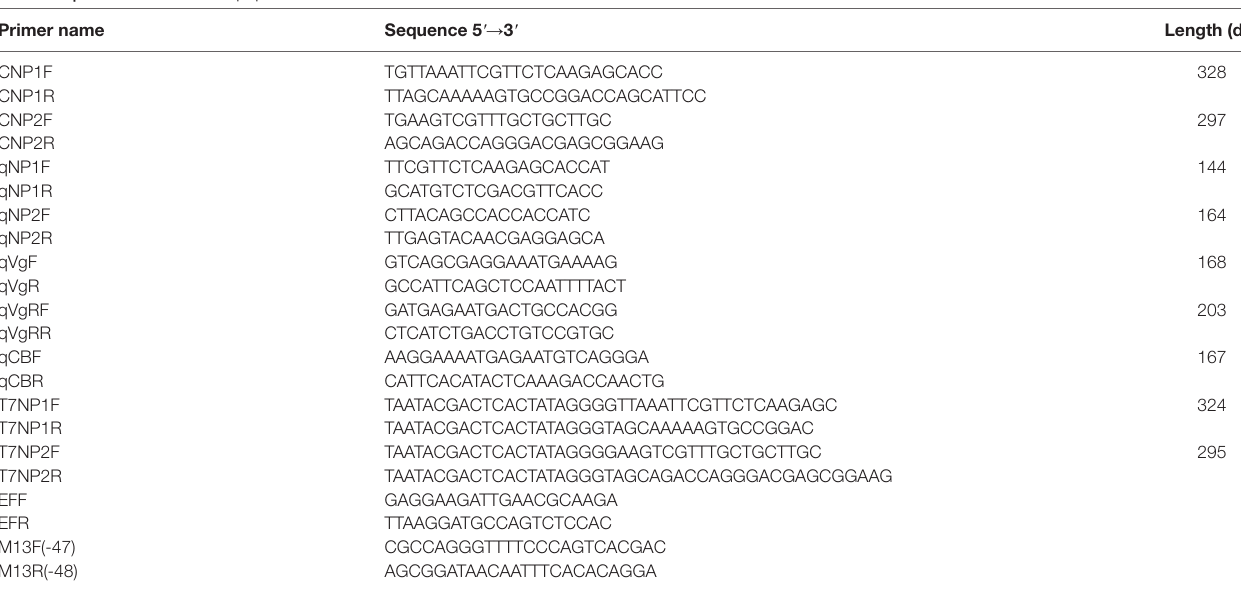
TABLE 2 | Primers used in this paper.